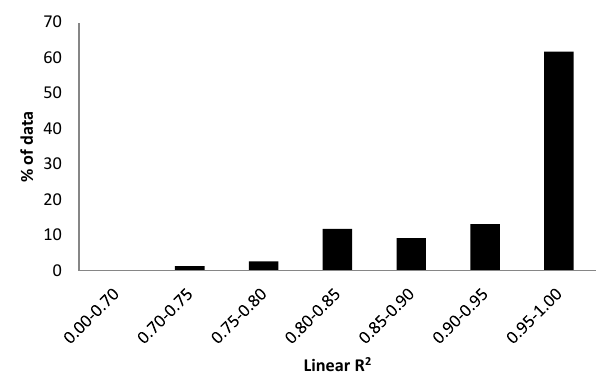
Fig. 1. Percentage of data for given ranges of coefficient of deter- mination ( R 2 ) of the linear regression, n =